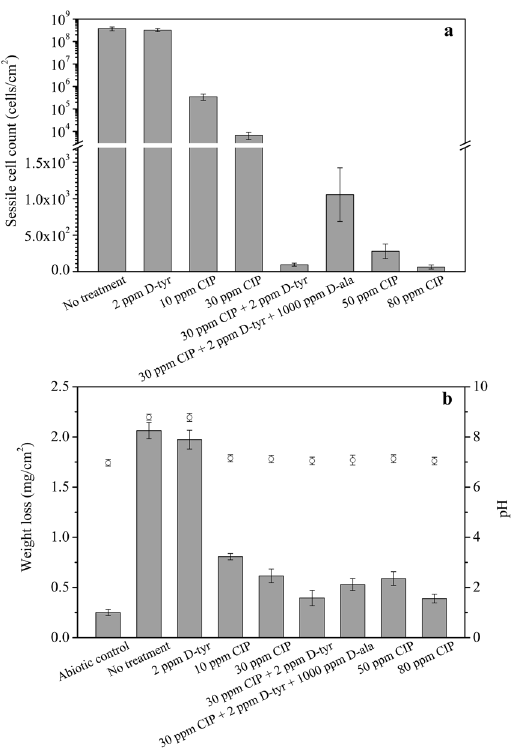
Figure 1. Sessile cell counts, specific weight losses and pH. ( a ) Sessile cell counts after the 7-day biofilm prevention test with different treatment chemicals in the culture medium. (Error bars represent standard deviations, statistical reference point n = 4). ( b ) Weight losses of coupons (bars) and pH values (circles) of the culture medium at the end of the 7-day biofilm prevention test. (Error bars represent standard deviations, statistical reference point n =